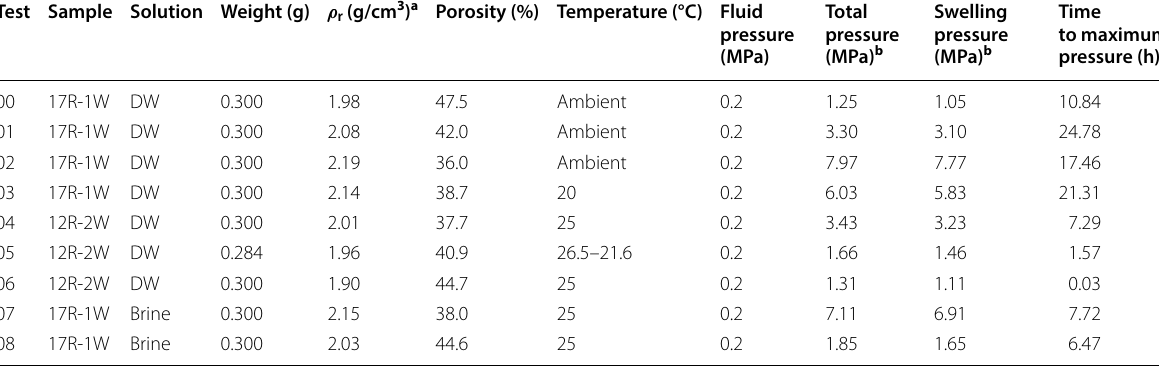
DW distilled water a Water-saturated sample density b Values represent the maximum pressures